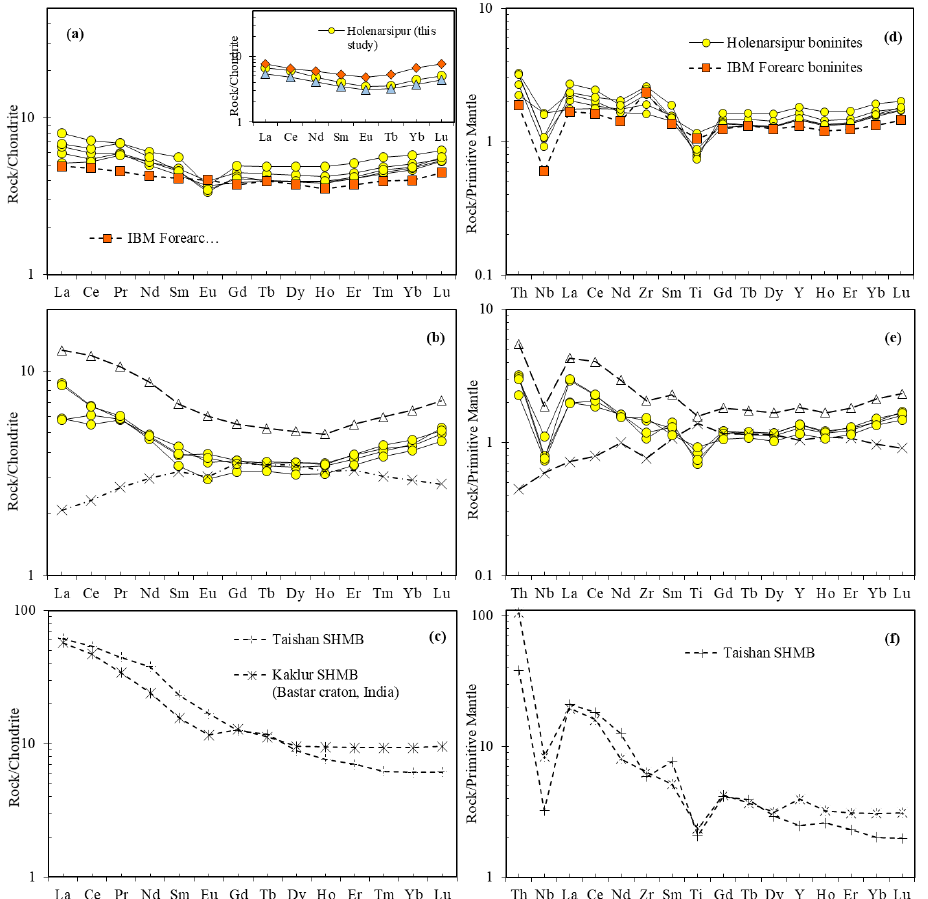
Figure 5. Chondrite normalized rare earth element (REE) patterns ( a – c ); and, ( d – f ) primitive mantle normalized trace element variation diagrams. Chondrite and primitive mantle values are from Sun and McDonough [17]. Data for Izu-Bonin-Mariana fore arc boninites in ( a , d ) is from Reagen et al. [2]. The REE patterns of the Phanerozoic boninites in ( a ) are plotted from Hickey and Frey [1], and shown for comparison. The data for Whundo boninites shown in ( b , e ) is from Smithies et al. [6]. Note the identical nature of the normalized REE and trace element patterns exhibited by the ~3.3 Ga Holenarsipur high-Si high-Mg volcanics in comparison to the ~3.1 Ga Whundo boninites. The patterns are converse to that displayed by the Kadihalli komatiites (Table 4) [13]. The Neoarchean siliceous high-Mg basalts in ( c , f ) Srivastava and Singh [19] and Peng et al. [20] are also shown for comparison. See text for details.